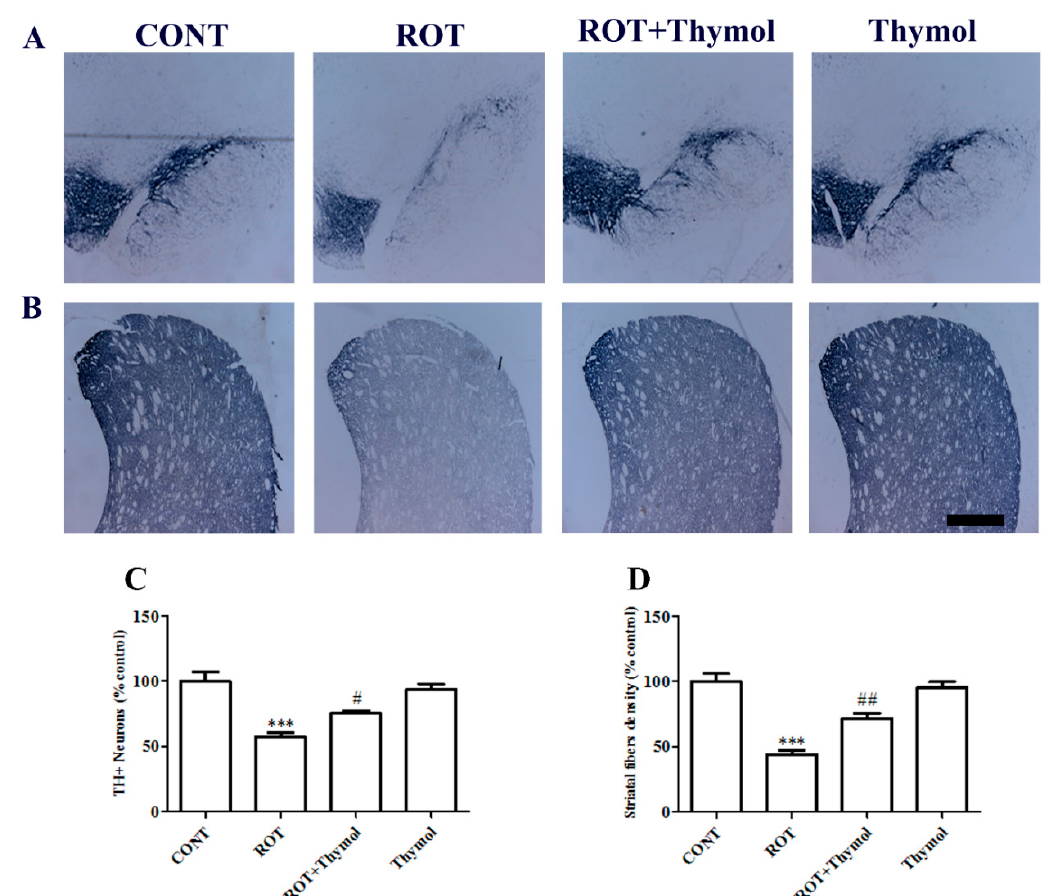
Figure 2. The illustrative photomicrograph showing expression of TH+ neurons in substantia nigra par compacta (SNc) ( A ) and TH-ir dopaminergic fibers in striatum ( B ). The scale bar is 100 µm. The expression of TH+ neurons and TH-ir fibers were reduced in the SNc region of rotenone (ROT) challenged rats as compared to vehicle injected rats in the CONT group. Thymol treatment to ROT challenged rats showed remarkable expressions of TH+ neurons and TH-ir fibers as compared to ROT injected rats. Quantification data showed significant (*** p < 0.001) decrease in the number of TH+ neurons and density of TH-ir fibers in ROT group rats compared to control rats. While thymol treatment to ROT injected rats showed significant (# p < 0.05; ## p < 0.01) increase in TH+ neurons and TH fibers density as compared to ROT alone injected rats ( C – D ).